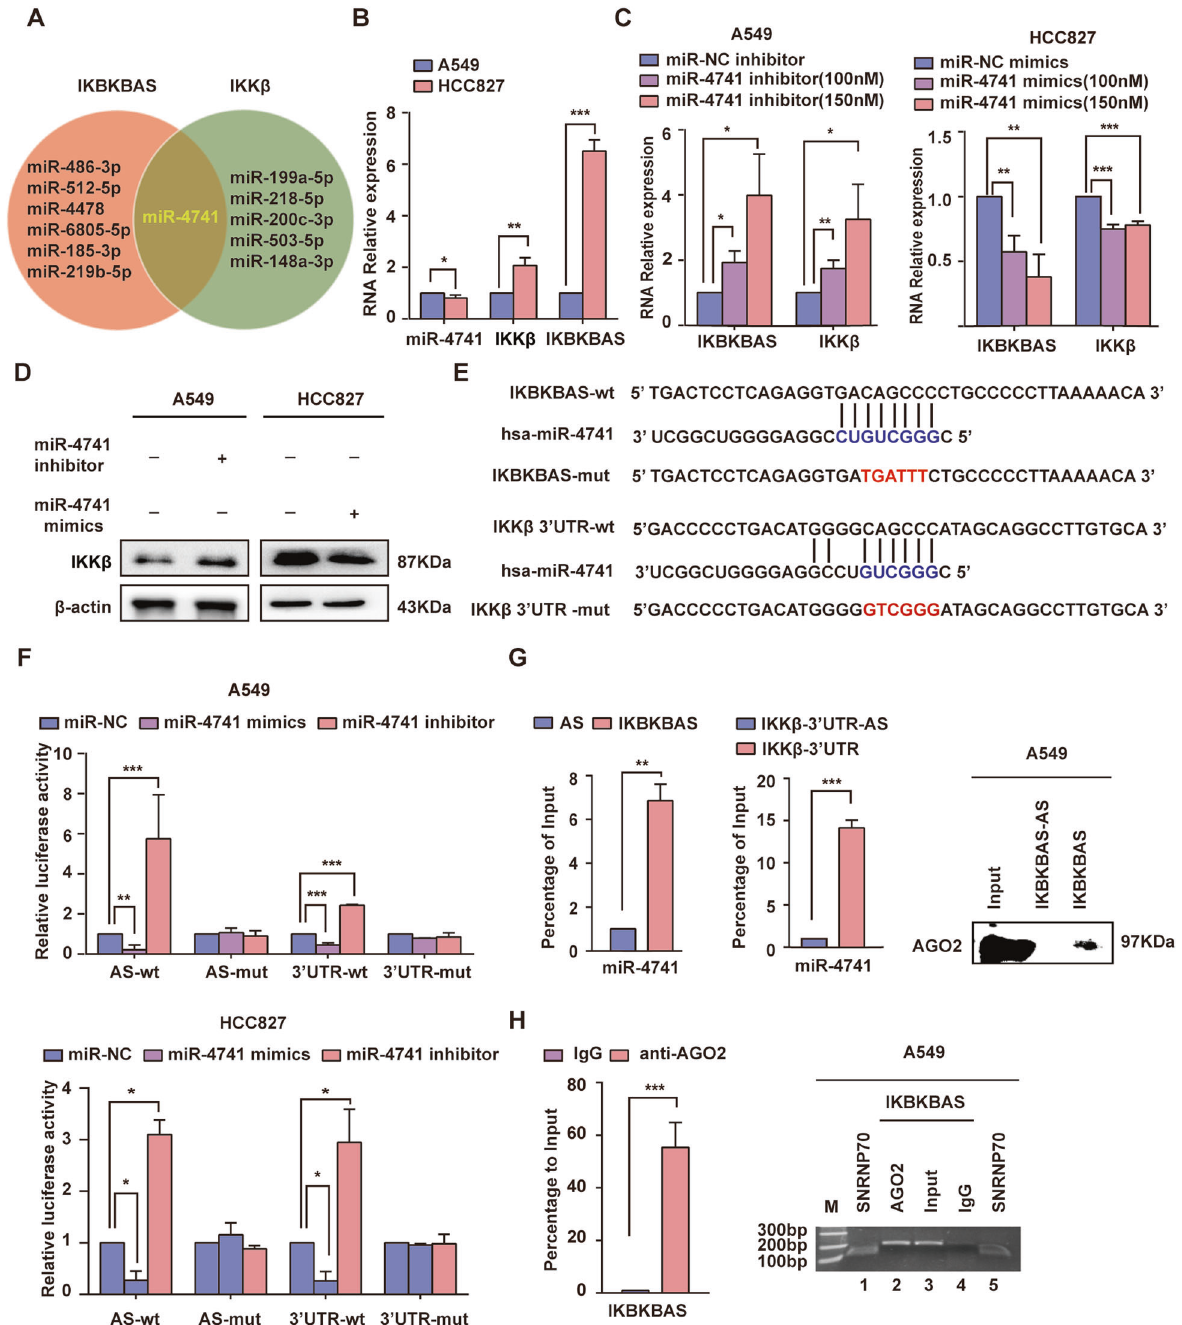
Fig. 5 IKBKBAS competes for binding of miR-4741 with IKK β mRNA. A The common miRNA that targeted to both IKBKBAS and IKK β mRNA predicted by RegRNA 2.0, Targetscan Human 7.1, and miRDB. B The relative expression of miR-4741, IKBKBAS, and IKK β mRNA in A549 and HCC827 cells were assayed by qRT-PCR. C Validation of the effect of miR-4741 inhibitor or mimics on expression of IKK β in A549 and HCC827 cells by qRT-PCR analysis. D The effect of miR-4741 inhibitor or mimics on expression of IKK β in A549 and HCC827 cells was assayed by western blot. E Schematic representation of the predicted MREs for miR-4741 on IKBKBAS or IKK β 3 ′ UTR, and the site mutagenesis design for the luciferase reporter. F Luciferase reporter assay con fi rmed the interaction between miR-4741 and IKBKBAS or IKK β 3 ′ UTR in A549 and HCC827 cells. A549 and HCC827 cells were co-transfected with miR-4741 mimic or miR-4741 inhibitor and pMIR-IKBKBAS-wt/mut or pMIR- IKK β -3 ′ UTR-wt/mut plasmids. miR-NC mimics or miR-NC inhibitor were also transfected as control. Transfected cells were harvested after 48 h and subjected to luciferase activity assay. G The association among IKBKBAS, miR-4741, IKK β 3 ′ UTR, and AGO2 was ascertained by RNA pull- down assay using A549 cell lysates. Left: Detection of miR-4741 by qRT-PCR in the sample pulled down using biotinylated IKBKBAS and IKBKBAS-AS (negative control) probes; middle: Detection of miR-4741 by qRT-PCR in the sample pulled down using biotinylated IKK β 3 ′ UTR and IKK β 3 ′ UTR-AS (negative control) probes; right: Detection of AGO2 by western blot in the sample pulled down using biotinylated IKBKBAS and IKBKBAS-AS (negative control) probes. H The association between IKBKBAS and Ago2 was ascertained by RIP assay using A549 cell lysates with an AGO2 antibody. The anti-SNRNP70 and IgG were used as positive and negative control, respectively. Left: qRT-PCR result; right: RT-PCR result (lane M: marker; lanes 2 – 4: IKBKBAS fragment, 208 bp; lane 1, 5: U1 snRNA,118 bp). Data show mean ± S.E.M., n ≥ 3, * P < 0.05, ** P < 0.01, *** P <